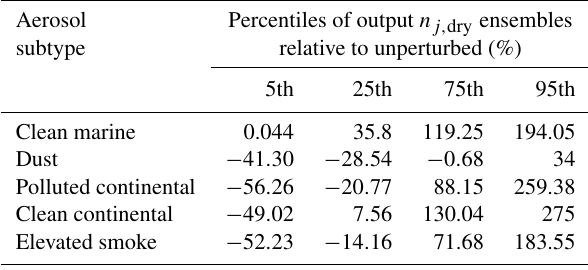
Table 3. Percentiles of output n j, dry ensembles estimated from the sensitivity analysis relative to that of the unperturbed